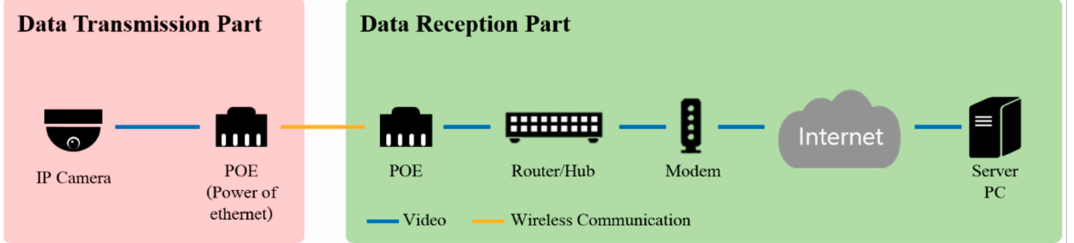
Figure 1. An example of a wireless communication network for recognizing behavior through CCTV using a complex HAR